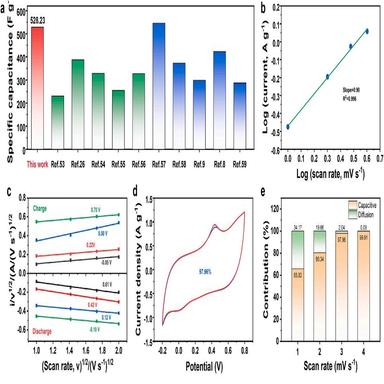
Electrochemical performance of the GCNC/MnO2-15 mM electrode. (a) Comparison of specific capacitance between current research studies and this work (green color: nanocellulose-based MnO2 composites; blue color: carbon-based MnO2 composites), 53–. (b) b-Value. (c) Plots of ν1/2 vs. I/ν1/2 under various potentials. (d) Capacitance contribution at a scan rate of 3 mV s − 1 . (e) Quantification of capacitive contributions at scan rates of 1–4 mV s − 1 .